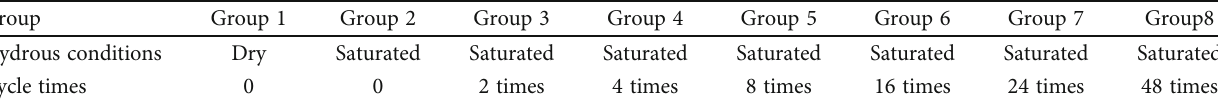
Table 2: State of each group of